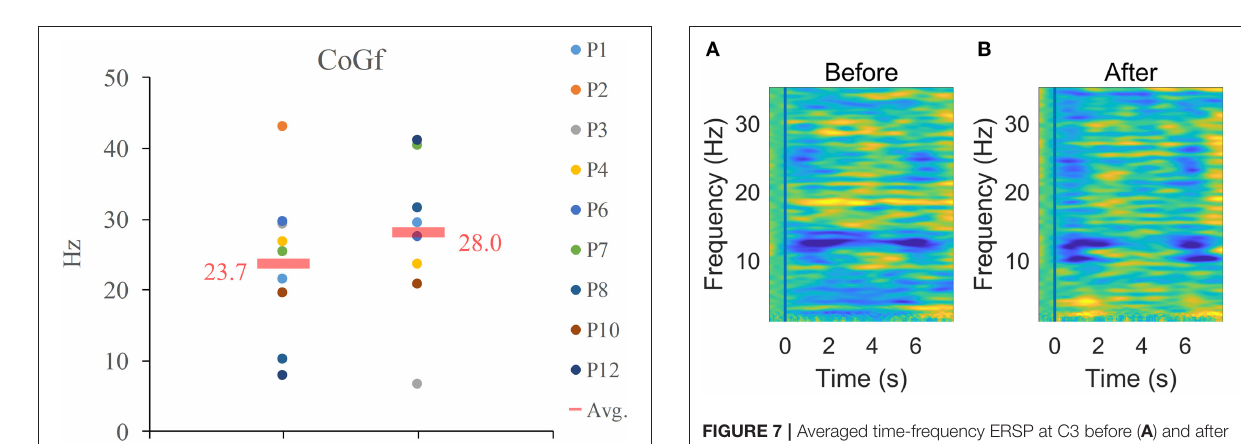
FIGURE 7 | Averaged time-frequency ERSP at C3 before ( A ) and after ( B ) NMES. The vertical blue line indicates the onset of the wrist